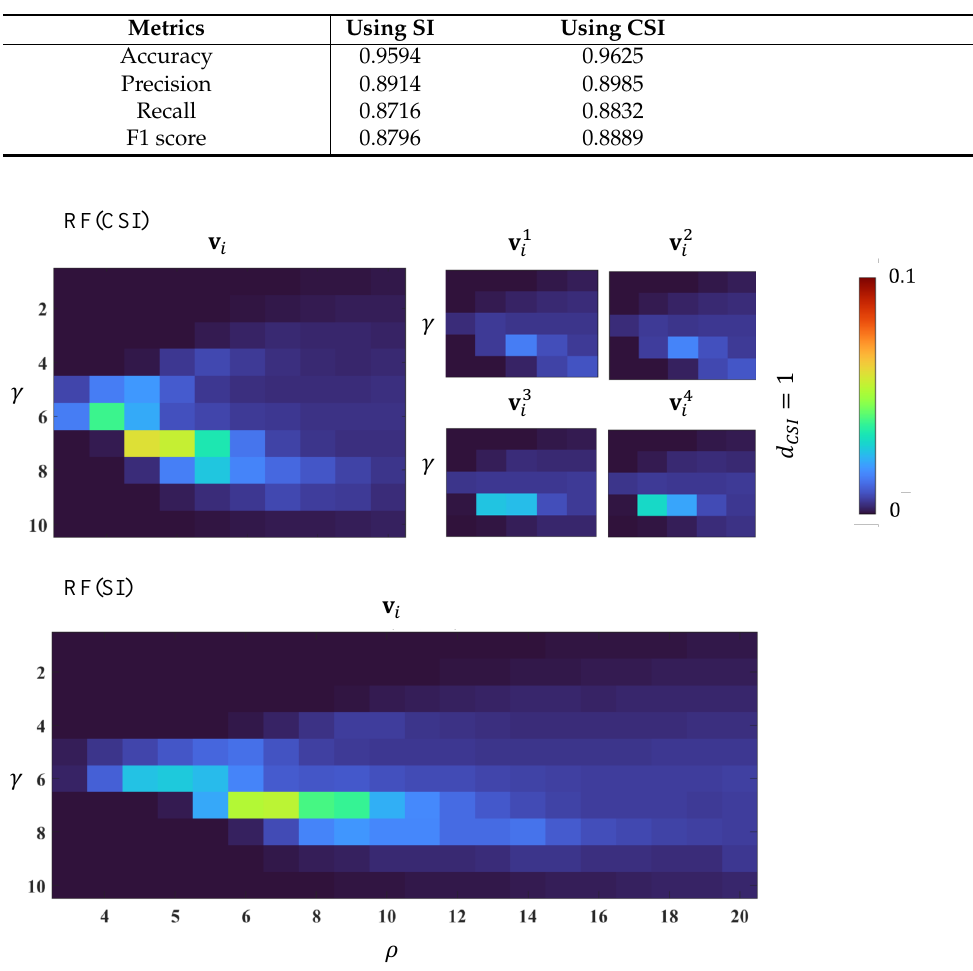
Table 3. Comparison of the representation performance of SI and CSI. The dimension of both SI and CSI feature vectors is 200.